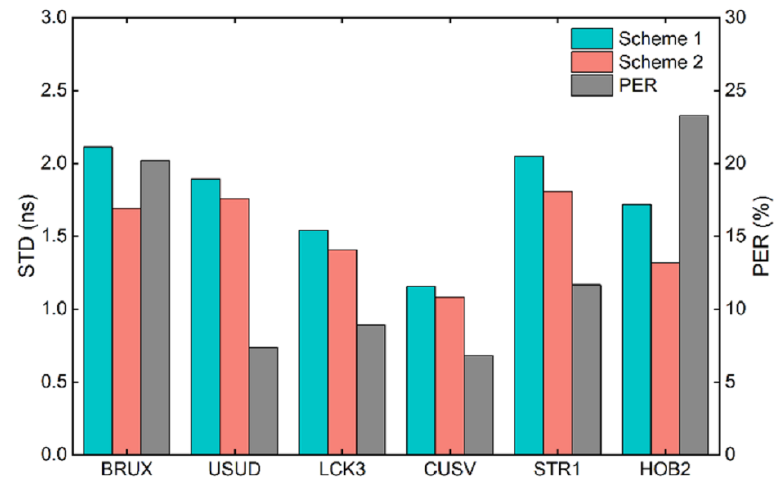
Figure 11. STDs of the receiver clock errors and the percentage improvement of scheme 2 compared with that of scheme 1 in STD.